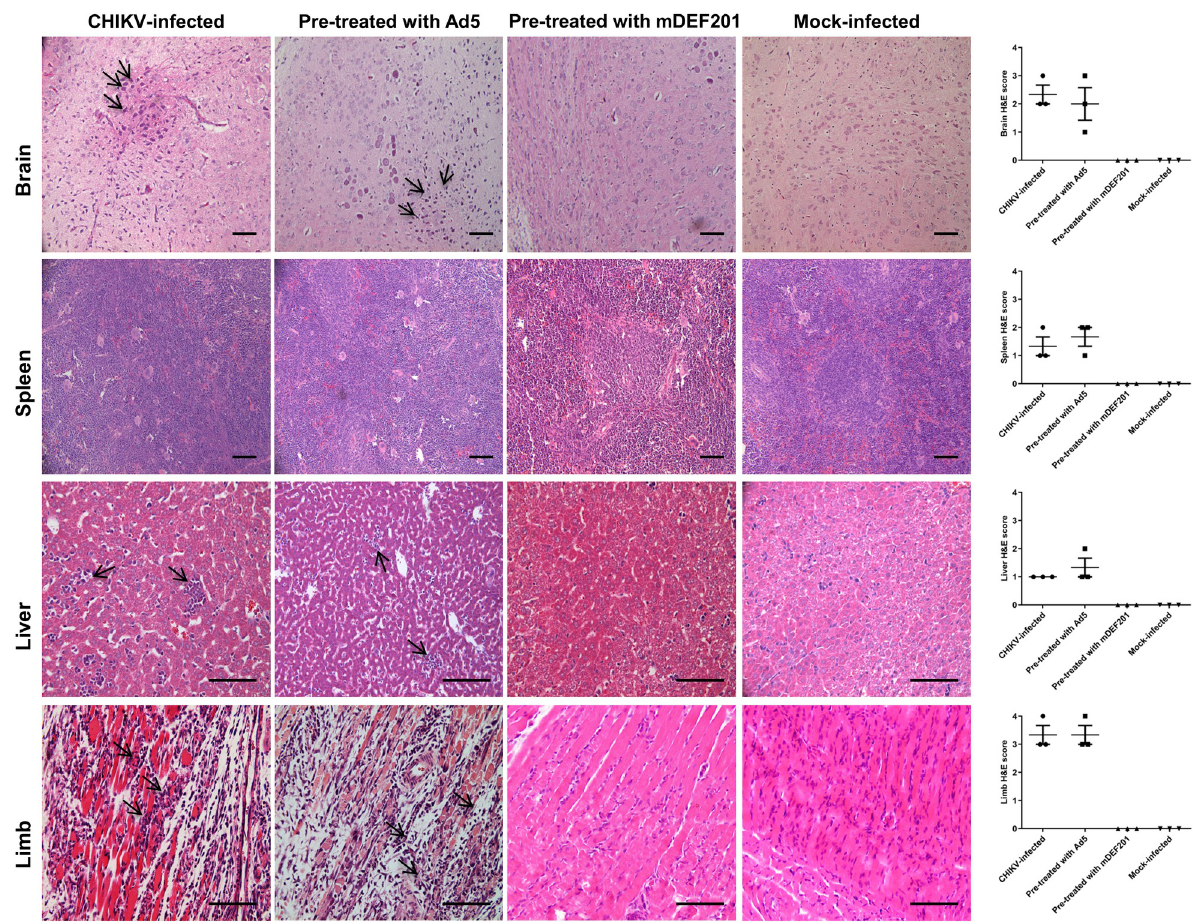
Fig 5. Histopathology analysis of CHIKV challenged mice. 6-day-old BALB/c mice were pre-treated with 5 x 10 6 PFU of mDEF201 per mouse 24 h prior to CHIKV infection. Brain, spleen, liver and limb muscle were harvested at 7 dpi and stained with hematoxylin and eosin (H&E). Arrows indicate areas of inflammation. Scale bar is 40 μ m. H&E-stained sections were scored for histopathological evidence and results are expressed as disease score of tissues. The brain tissues were scored according to the degree of inflammatory infiltrates using a 0–4 point scale, in which 0 = no damage, 1 = mild, 2 = moderate, 3 = severe and focal, and 4 = severe and diffuse. The spleen and liver samples were scored base on the necrosis, with 0 = none, 1 = mild, 2 = moderate, 3 = severe and 4 = very severe. The limb muscle samples were scored according to degree of inflammation and infiltration: 0 = no inflammation, 1 = minimal inflammatory infiltration, 2 = mild infiltration, 3 = moderate infiltration with moderate edema, 4 = severe infiltration with edema. Values present the mean and individual value.